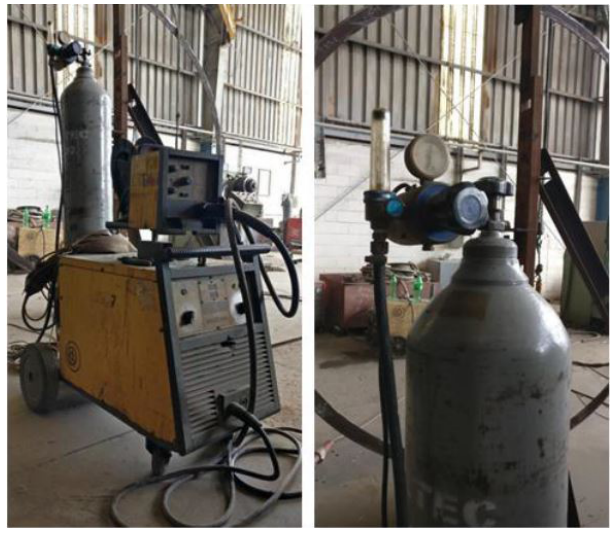
Figure 1. Gas metal arc welding (GMAW) process setup used for welding data